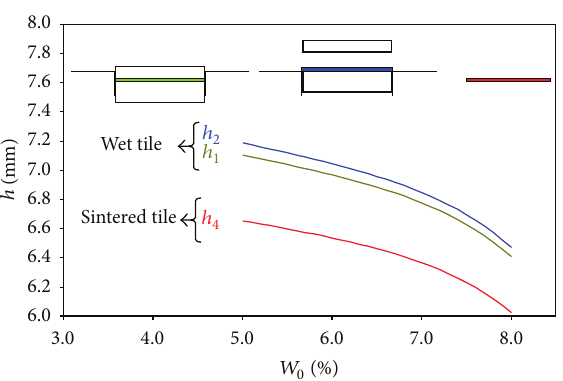
Figure 13: Influence of the powder moisture ( 𝑊 0 ) on the tile thickness ( ℎ ) along the fabrication steps, for a maximum pressure of 40 MPa.